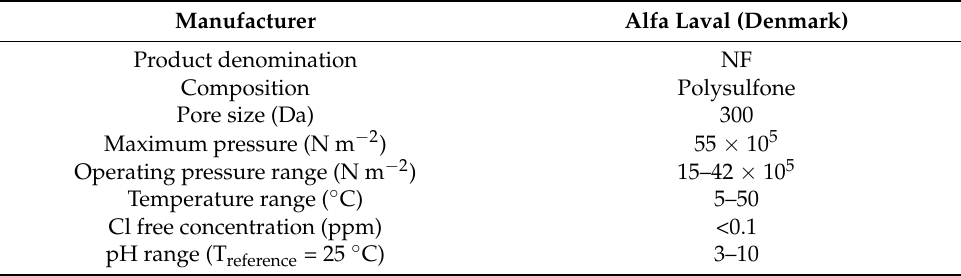
Table 1. Main technical characteristics of nanofiltration